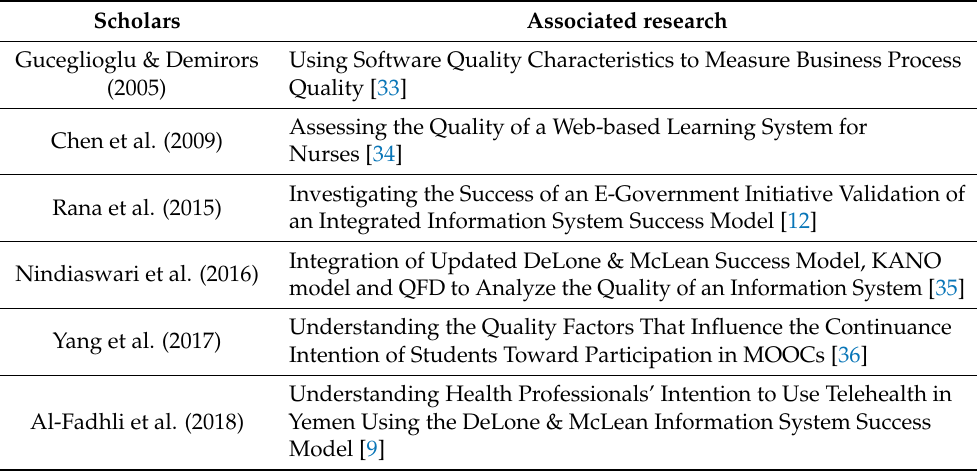
Table 2. Related research of the Information System Success Model.